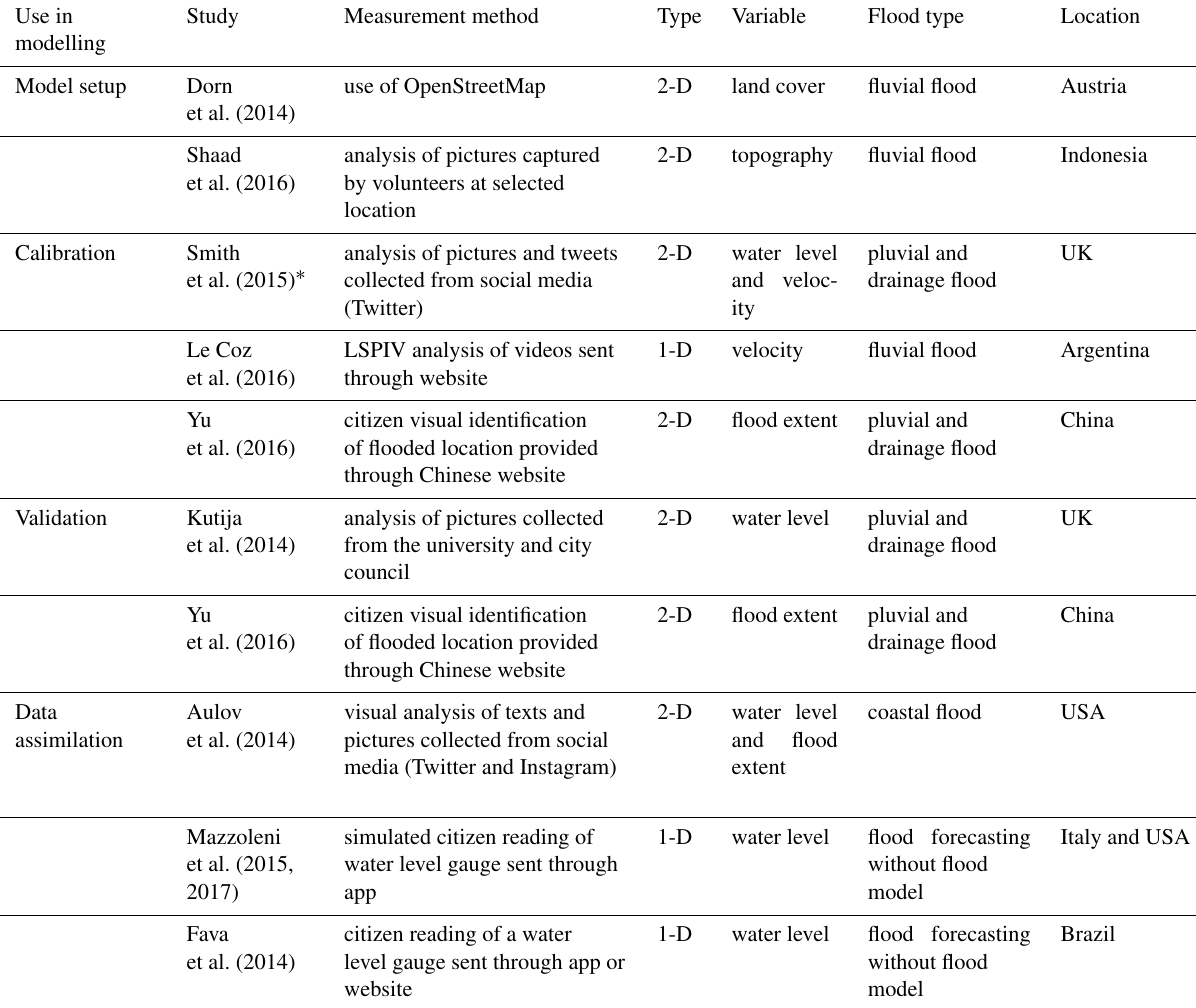
Table 5. Scientific literature on crowdsourced data used in flood modelling. Use